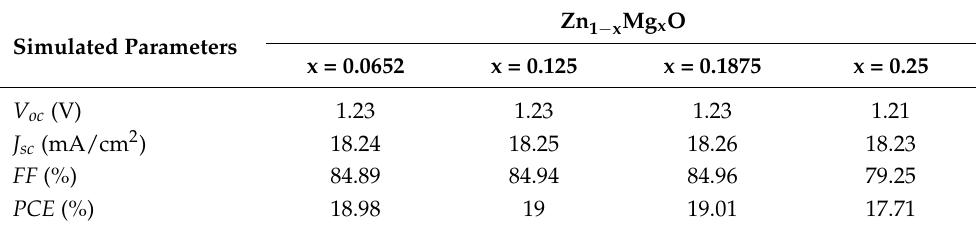
Table 5. C 2 N/ZMO-based solar cell parameters after